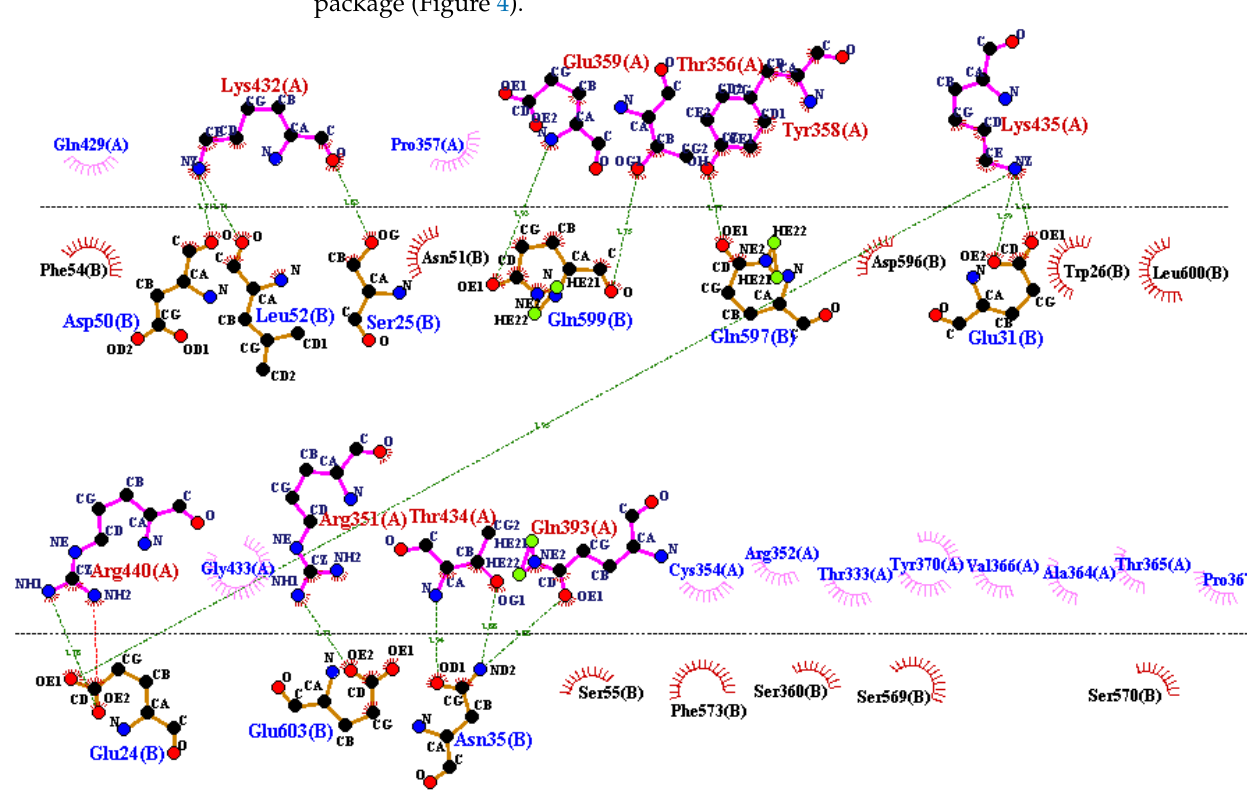
Figure 4. Possible interactions between vaccine construct and TLR4 obtained by docking studies and visualized through the DIMPLOT server. The green lines show hydrogen bond interactions between TLR4 receptor’s B chain amino acids (labeled with A at the top section of the lines) and the vaccine construct amino acids (labeled with B at the bottom section of the